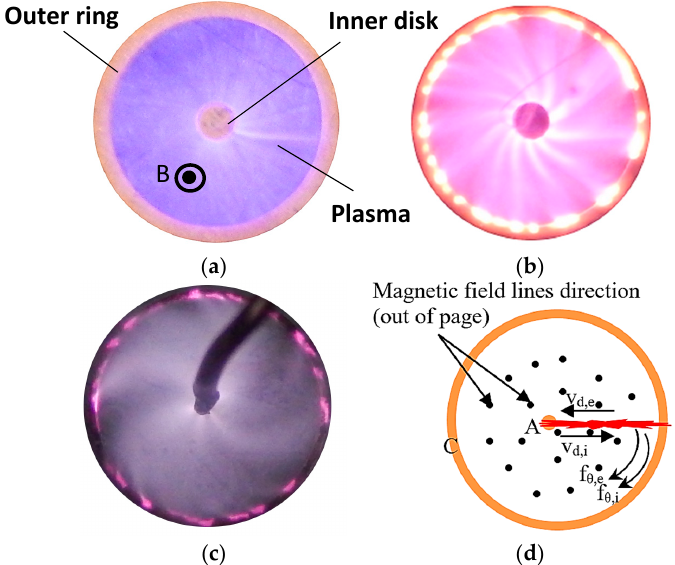
Figure 18. Rotating glow discharges at atmospheric pressure for: ( a ) Helium; ( b ) Neon; and ( c ) Argon; ( d ) Schematic of different components of Lorentz forces exerted on the glow discharge. The rotations of Neon and Argon glow have some interesting spatial feature as seen from the “spokes” in their rotations [29,39]. B in (a) indicates the magnetic field, A in (d) indicates anode, and C in (d) indicates cathode.